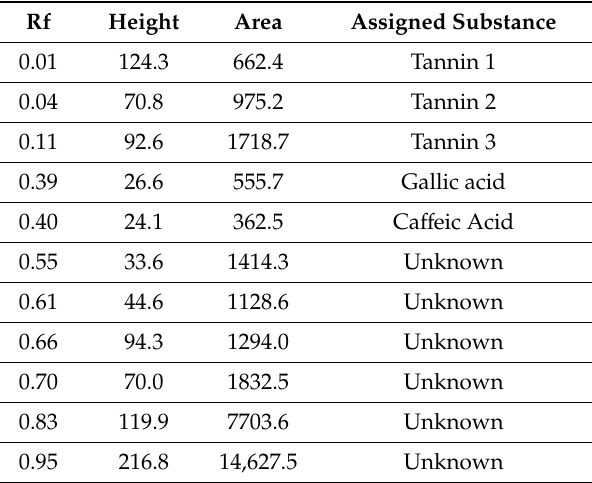
Table 4. HPTLC Tannin profile of A. aethiopicum methanolic